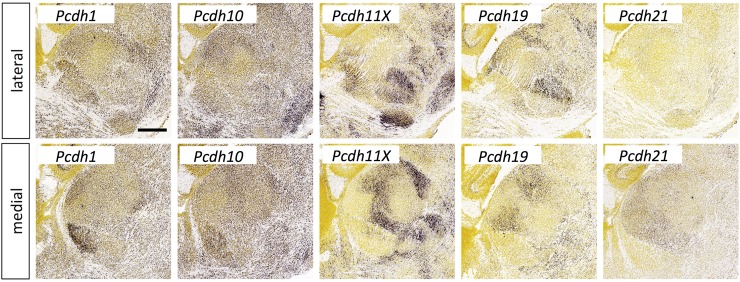
Protocadherin expression in the thalamus at E18.5.In situ hybridization data from sagittal sections of the thalamus at E18.5 obtained from the devABA revealed differential patterns of expression of Protocadherin (Pcdh) 1, 10, 11X, 19 and 21. See text for details. Two representative and equivalent sections are shown for each protocadherin, one lateral and the other medial (see S8 Fig for details on how the sections were selected). Scale bar in Pcdh1: 424 μm.